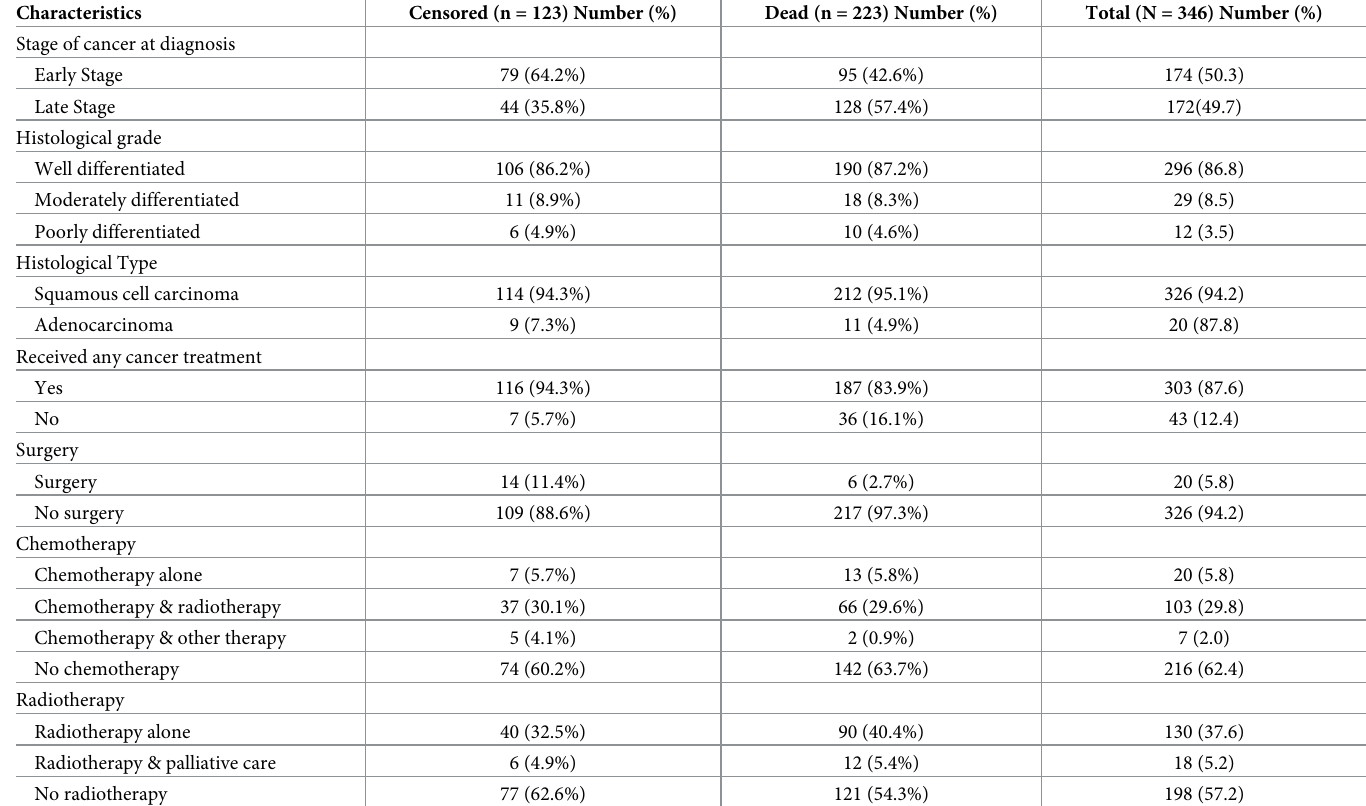
Table 3. Clinical and pathological characteristics among CCP in TASH from July 2014 –July